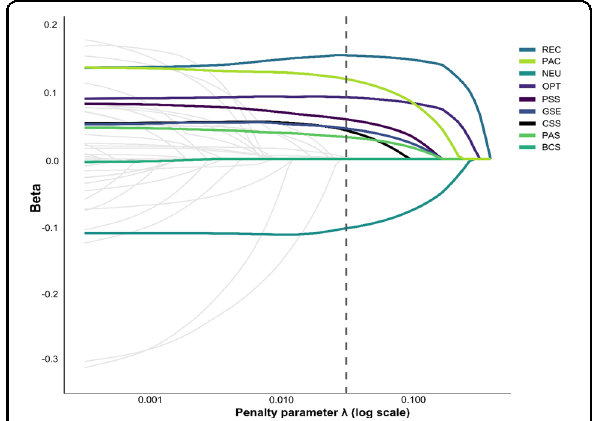
Fig. 2 Combined multi-variable analysis (LASSO) of the relative associations of resilience factors and covariates with resilience (RES C ). To identify the strongest of the partly correlated resilience factors, sparse regression was performed with an optimal penalty term λ (vertical broken line), as determined by cross-validation. Resilience factors are indicated in color, covariates in gray. The initial position of a curve on the y -axis signi fi es the association of the corresponding resilience factor or covariate with RES C in the case of very low penalization. By increasing λ ( x -axis), regression coef fi cients ( β ) get increasingly drawn to zero, to leave only the strongest associations. The order of resilience factors in the color legend corresponds to their determined relative strengths (absolute values) at optimal λ (broken line). Except for BCS (behavioral coping style), all resilience factors were selected in all 800 repeated LASSO runs, indicating strong replication